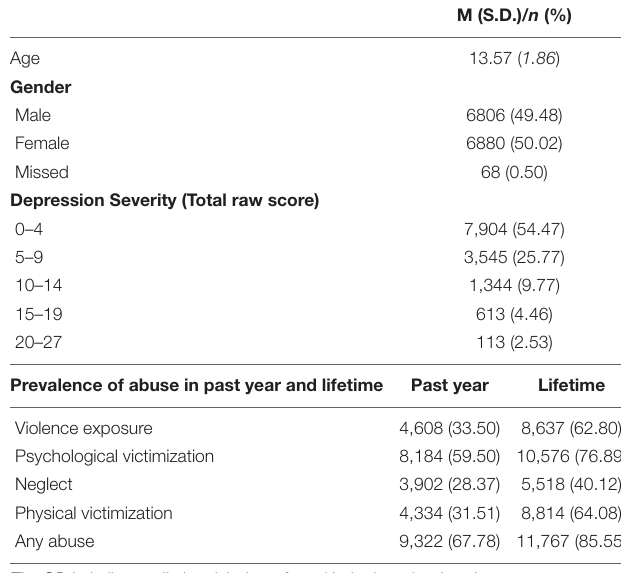
TABLE 1 | Demographics, depressive severity and abuse rate of the participants ( n =